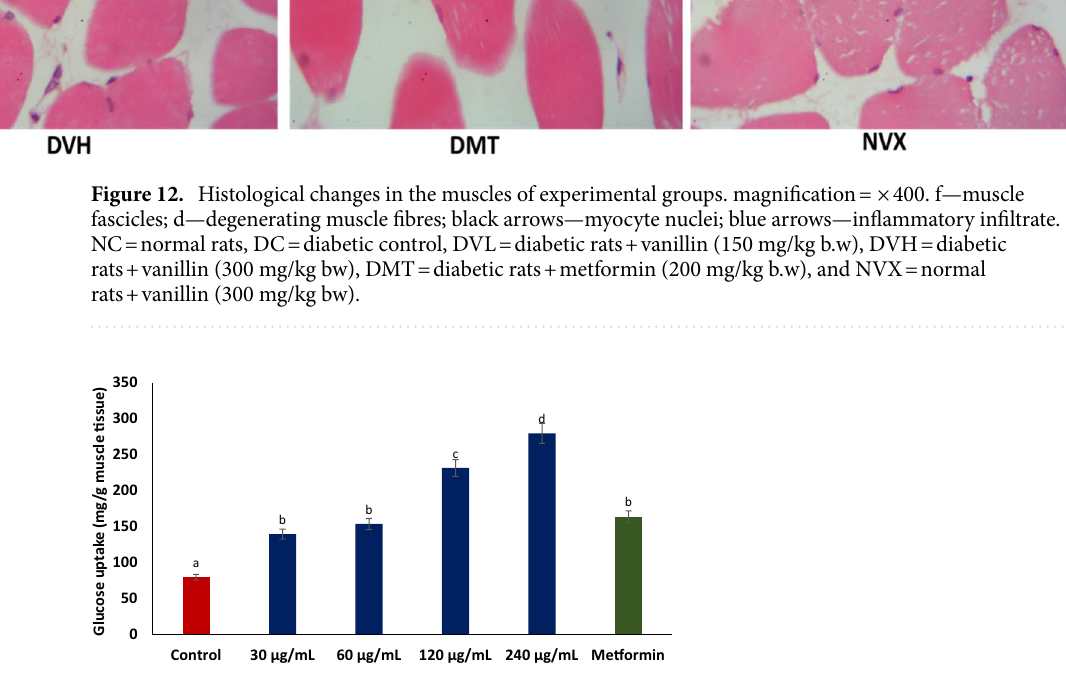
Figure 13. Effect of vanillin on glucose uptake in isolated rat psoas muscle. Data = mean ± SD; n = 3. a-d Values with different letters above the bars for a given concentration are significantly ( p < 0.05) different from each